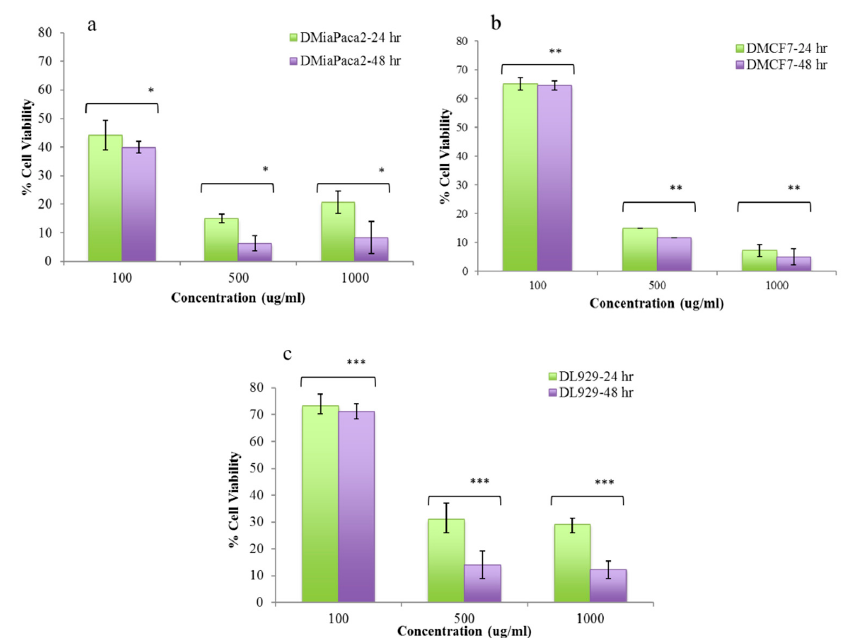
Figure 10. ( a – c ) Percent relative cytotoxicity of native luminespib in concentration and time-dependent manner towards MiaPaCa-2, MCF-7 and L929 cell lines. The study shows statistical significance of *, **, *** p < 0.05 within various groups marked in figure. The student t test carried out by comparing the lower concentration (100 µg/mL) treated group with high concentration (500 and 1000 µg/mL) treated group for each cell line.